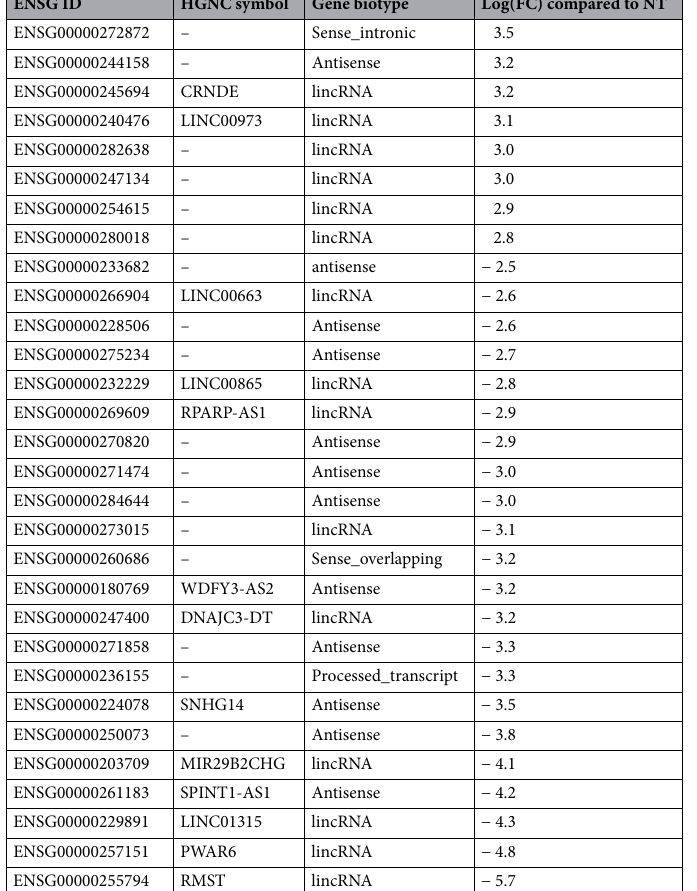
Table 7. Top 30 lncRNAs specific for